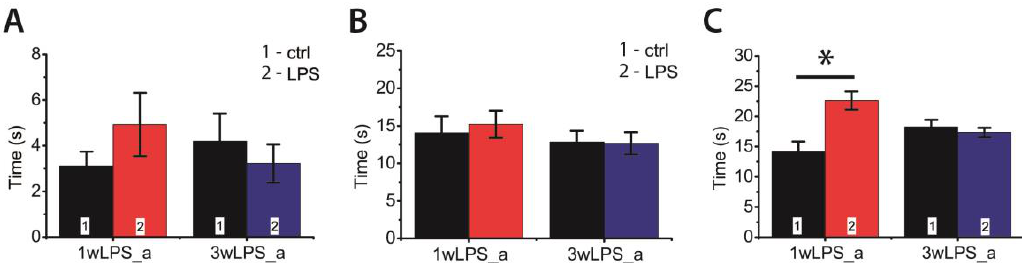
Figure 9. The behavior of P90 rats in the open field-test, which were treated with LPS during the first (1wLPS_a) or third (3wLPS_a) weeks. ( A ) Total time of hole exploration (interaction time × treatment: F 1,45 = 1.77; p = 0.19; time: F 1,45 = 0.09; p = 0.77; treatment: F 1,45 = 0.16; p = 0.69); ( B ) Time of locomotion (interaction time × treatment: F 1,45 = 0.14; p = 0.71; time: F 1,45 = 1.14; p = 0.29; treatment: F 1,45 = 0.08; p = 0.78); ( C ) Duration of movement on place (interaction time × treatment: F 1,45 = 13.21; p < 0.01; time: F 1,45 = 0.25; p = 0.62; treatment: F 1,45 = 8.41; p < 0.01). * p < 0.05 (Tukey post hoc